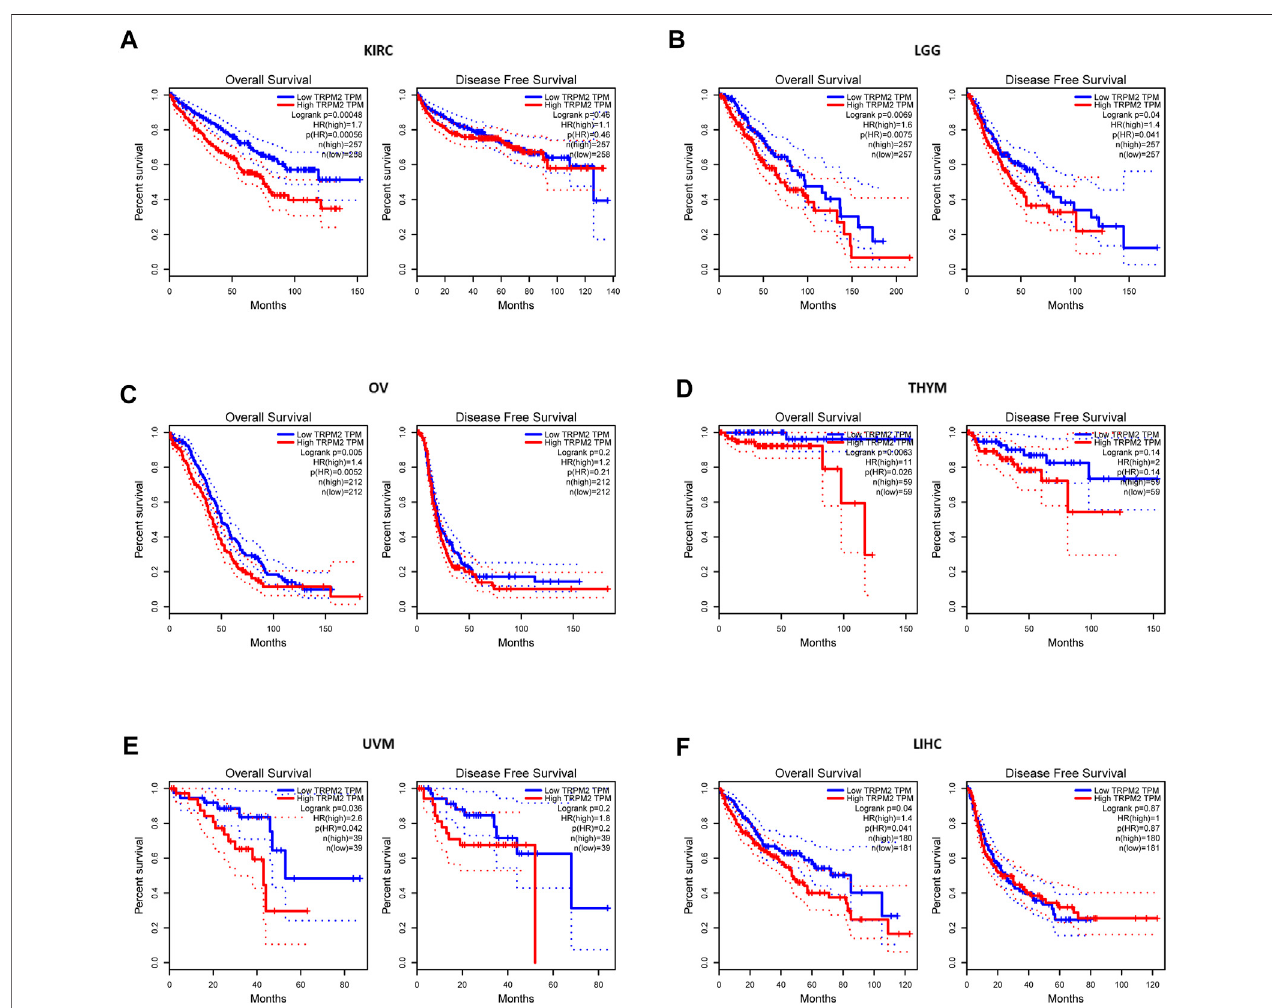
FIGURE2| ComparisonofthesurvivalcurvesofTRPM2expressionindifferentcancersintheGeneExpressionPro fi lingandInteractiveAnalysis(GEPIA)database. Correlation curves between the level of TRPM2 and overall survival (OS) and disease-free survival (DFS) of kidney renal clear cell carcinoma (KIRC) (A) , lower-grade glioma(LGG) (B) ,ovarianserouscystadenocarcinoma(OV) (C) ,thymoma(THYM) (D) ,uvealmelanoma(UVM) (E) ,andliverhepatocellular carcinoma(LIHC) (F) patients. Red curve represents patients with high expression of TRPM2. Blue curve represents patients with low expression of